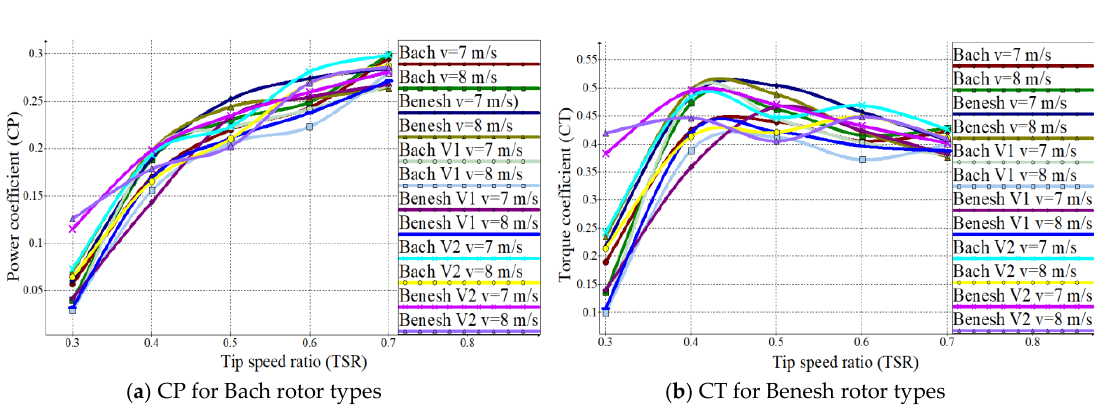
Figure 13. Power and torque coefficients for analyzed rotor models.